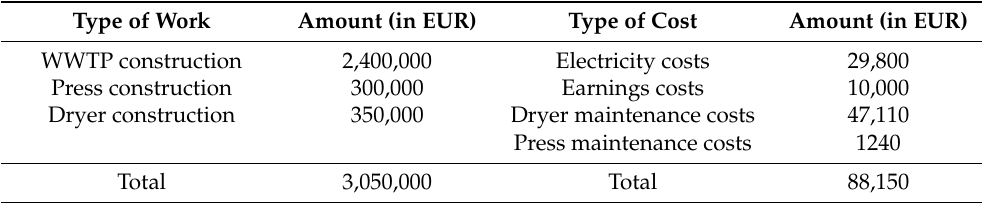
Table 6. Structure of investment costs and annual operating costs of the project.